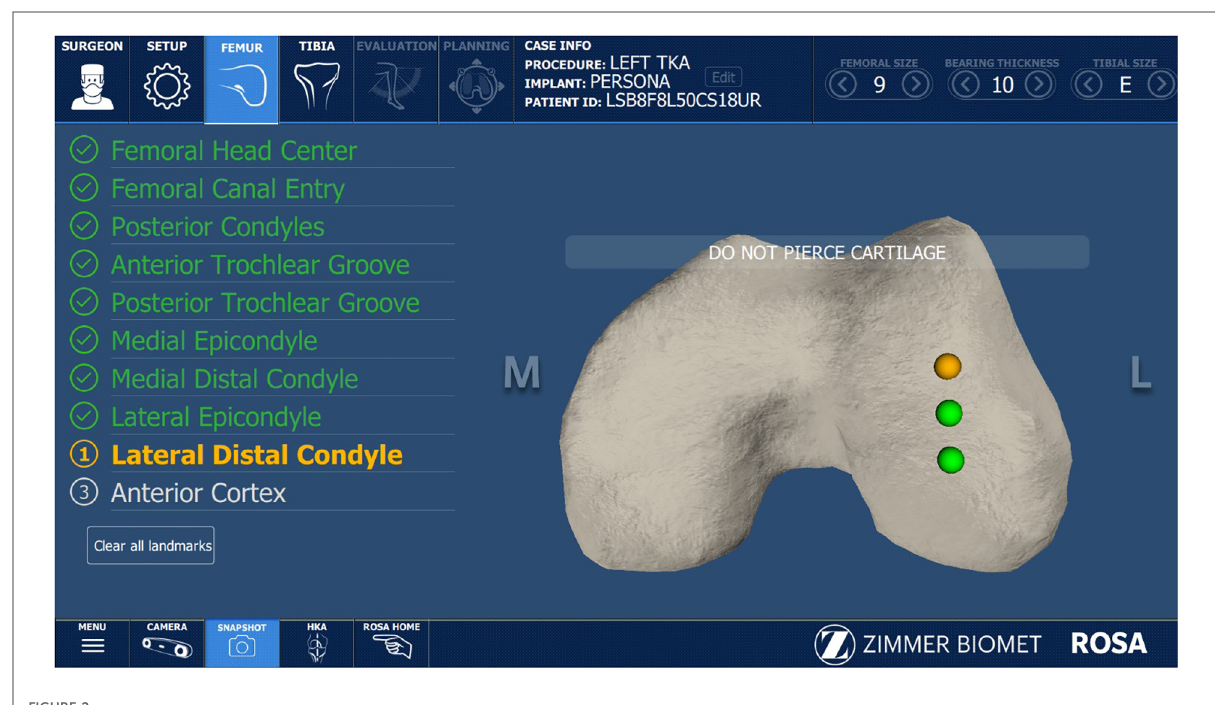
FIGURE 2 Registration screen displaying lateral distal condyle